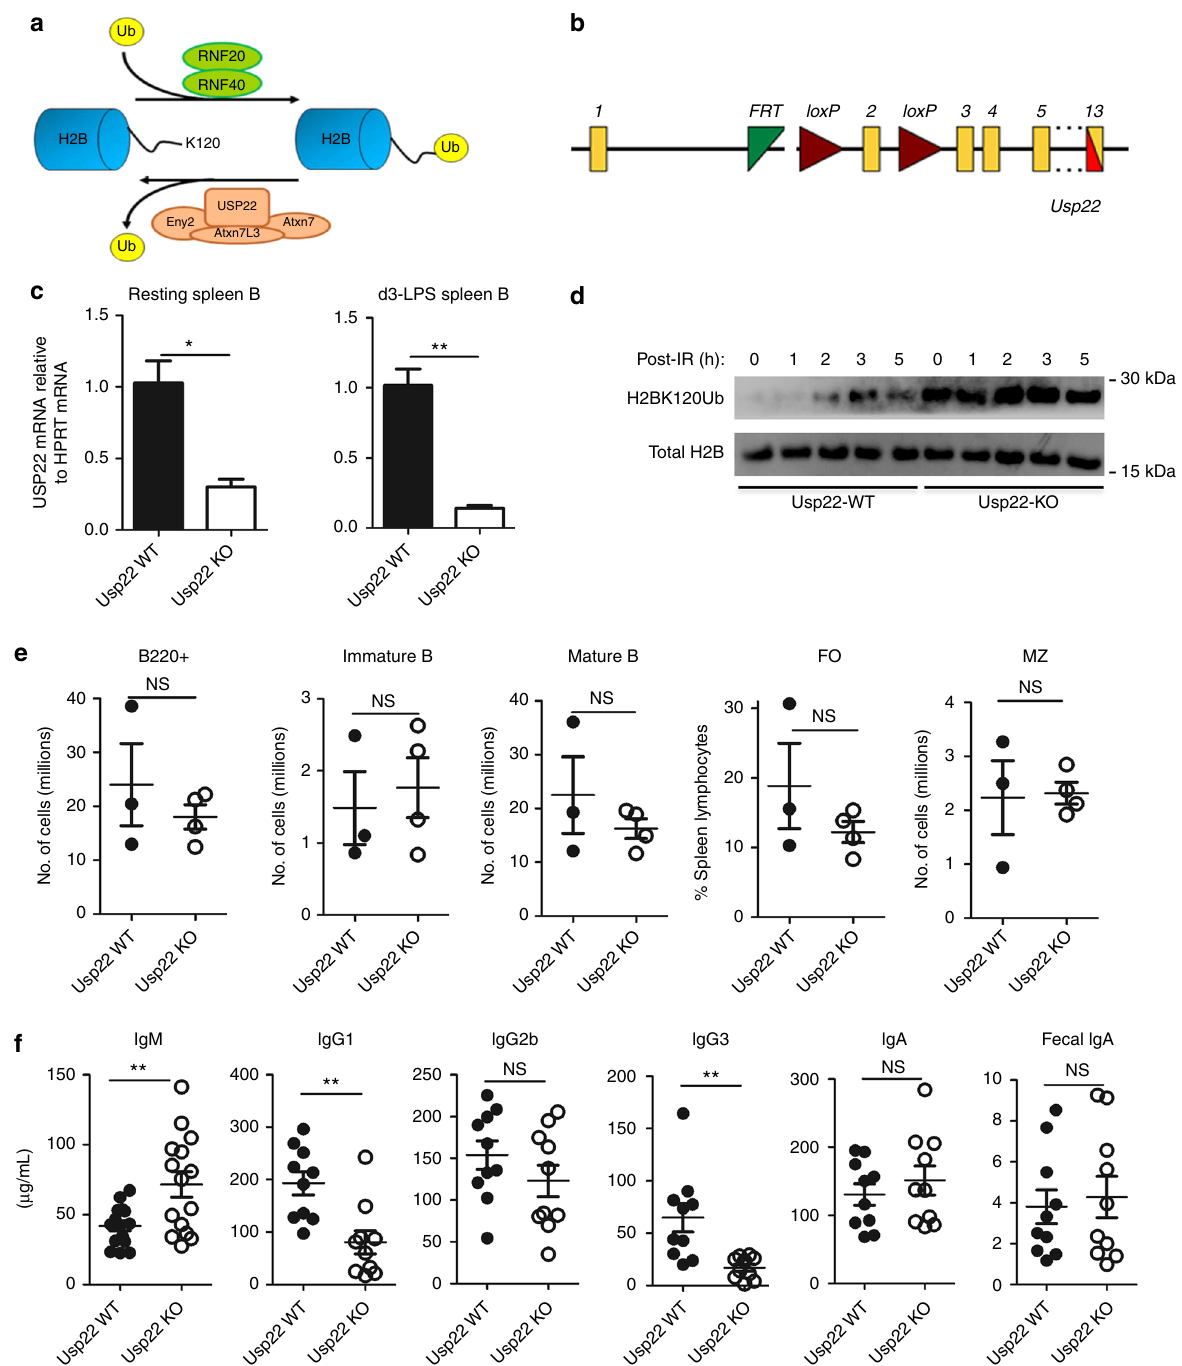
Fig. 1 Spleen B-cell pro fi les and total Ig isotype analysis of Usp22 KO or WT mice. a Schematic showing the dynamic regulation of histone H2B ubiquitination (Ub). Addition of ubiquitination to H2B is mediated by RNF20/RNF40, while the removal of ubiquitination from H2B is mediated by SAGA complex that is composed of Usp22, Eny2, Atxn7, and Atxn7L3. b The structure of targeted usp22 locus. The protein-encoding exon 2 (133 bp) of the usp22 gene was fl anked by loxP sites (triangles). Usp22 fl ox/ fl ox mice are bred to CD19-cre or Mb1-cre mice to delete exon 2, leading to disruption of usp22 gene expression speci fi cally in B cells. c Spleen B cells were puri fi ed from CD19-cre-Usp22 KO mice or WT littermates. qPCR analysis of Usp22 mRNA was performed with resting spleen B cells or B cells that were stimulated with LPS for 3 days ex vivo ( n = 3 mice per group). Data represent two independent experiments. d Spleen B cells from CD19-cre-Usp22 KO and WT littermate mice were stimulated with LPS for 2.5 days, exposed to 8 Grays of γ -radiation, and then collected at various time points for western blot analysis of H2B monoubiquitination (H2BK120Ub). Data represent four independent experiments. e Absolute numbers analysis of spleen B cells from CD19-cre-Usp22 KO and WT littermates. FO, follicular B cells; MZ, marginal zone B cells. Data represent two independent experiments each with three to four mice per group. f Serum analysis of various Ig isotypes in unimmunized CD19-cre- Usp22 KO and WT littermates, as well as fecal IgA from the same mice ( n = 10 mice per group). Data in c , e , and f were presented as mean ± SEM and were analyzed using two-tailed unpaired Student ’ s t -test. * p < 0.05 and ** p < 0.01; NS, not signi fi